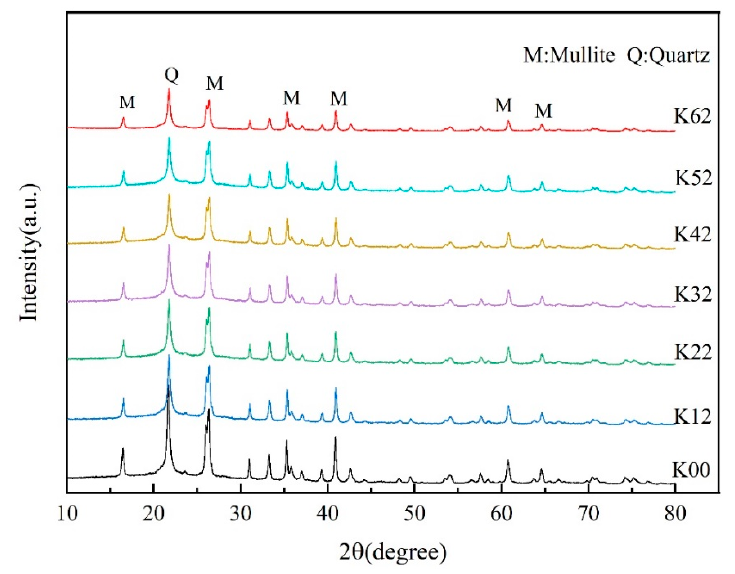
Figure 6. XRD di ff ractograms of original and modi fi ed kaolin.